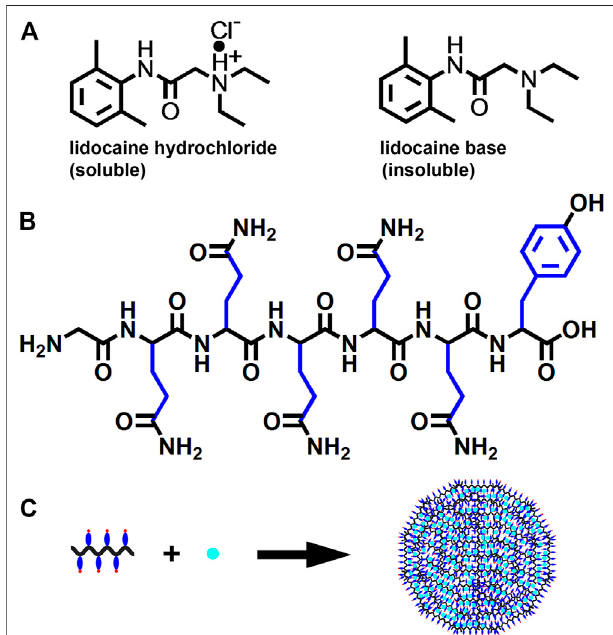
FIGURE 8 | Schematic illustration of LNPs preparation. (A) chemical structure of LH and LB. (B) chemical structure of GQY peptide with hydrophobic motifs in side-chain shown in blue. (C) proposed model for the formation of LNPs.